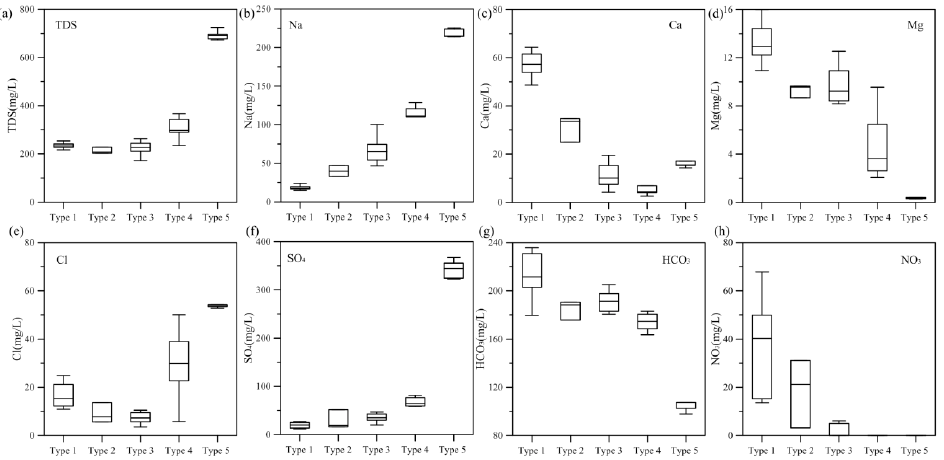
Figure 4. The Box and Whisker plots of ( a ) total dissolved solids (TDS) content; ( b ) Na content; ( c ) Ca content; ( d ) Mg content; ( e ) Cl content; ( f ) SO 4 content; ( g ) HCO 3 content; and ( h ) NO 3 content for the